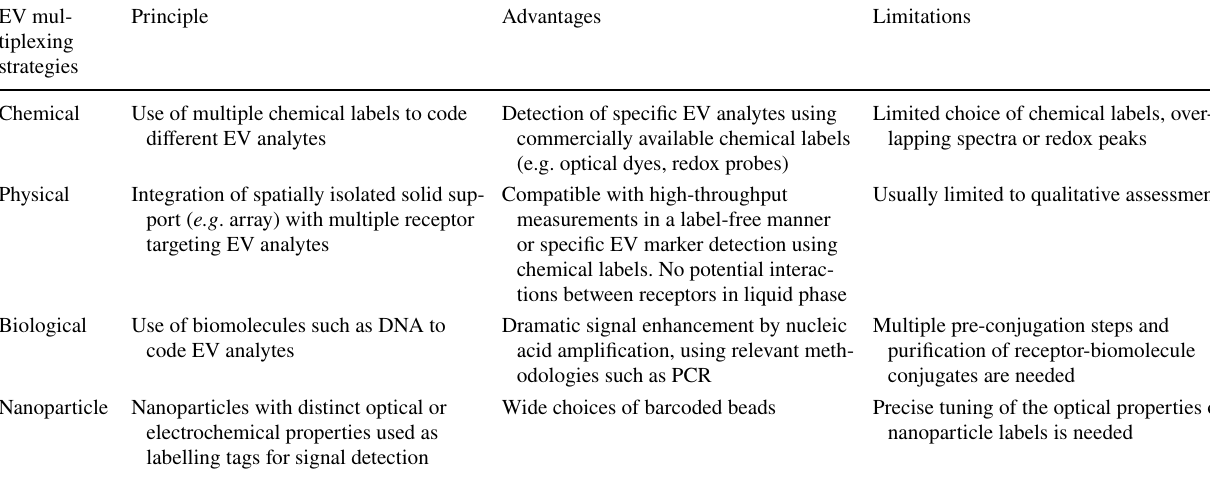
Table 2 Summary of the different EV multiplexing strategies